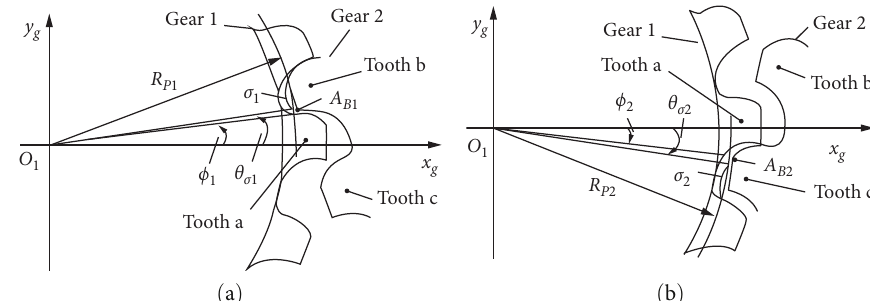
F IGURE 11: Interference diagram of the tooth pro fi le end points.